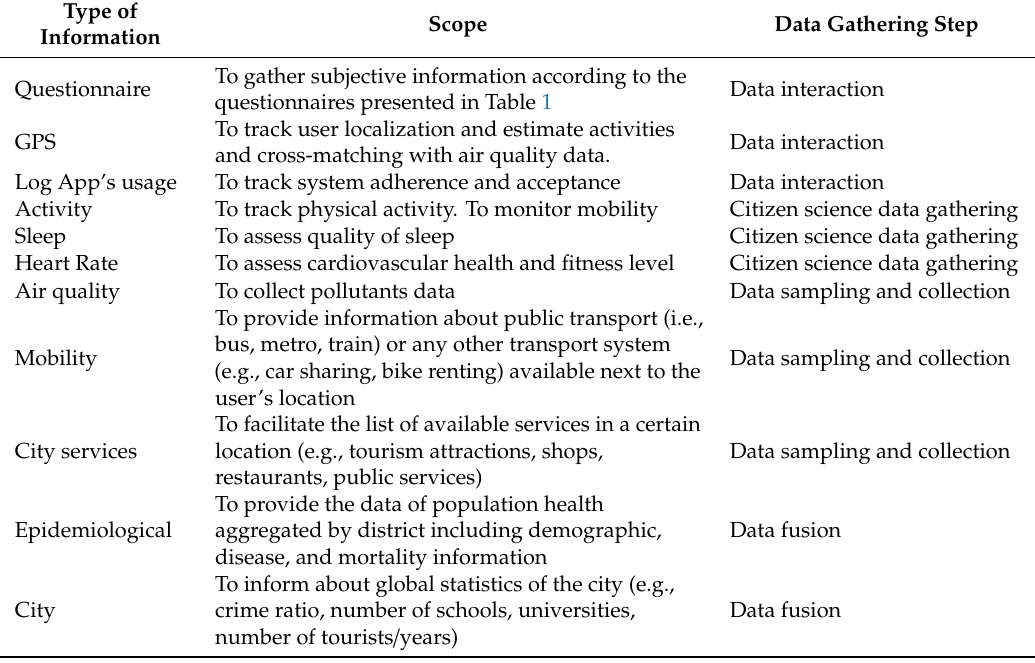
Table 2. Type of data gathered and